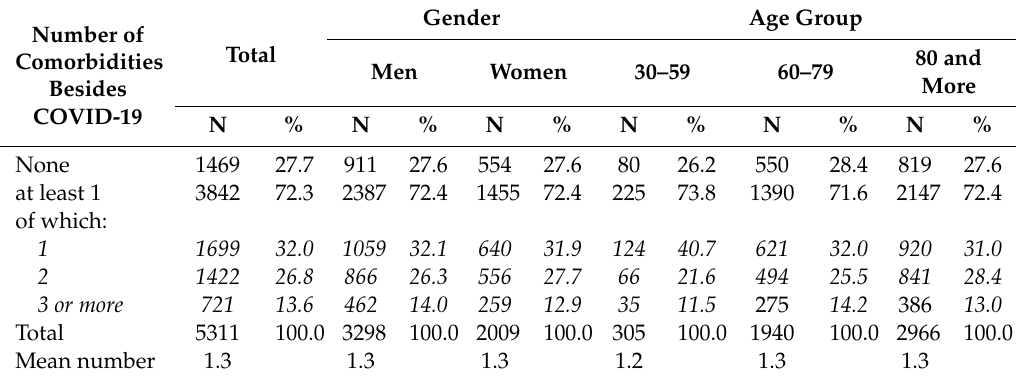
Table 2. Number of comorbidities by gender and age group.